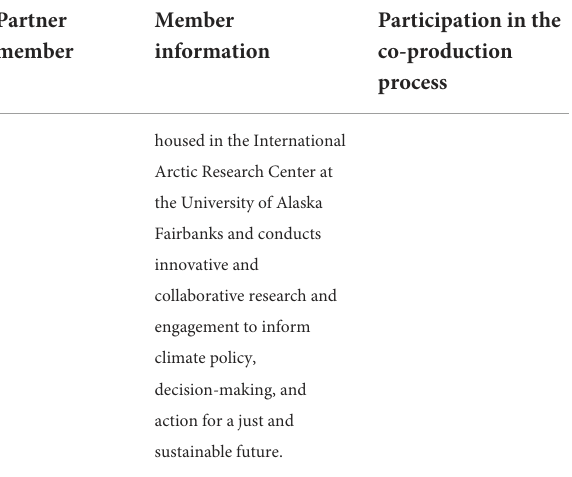
TABLE 1 Description of each entity in the Kake Climate Partnership, including their primary role in the Partnership. Description of Kake climate partnership